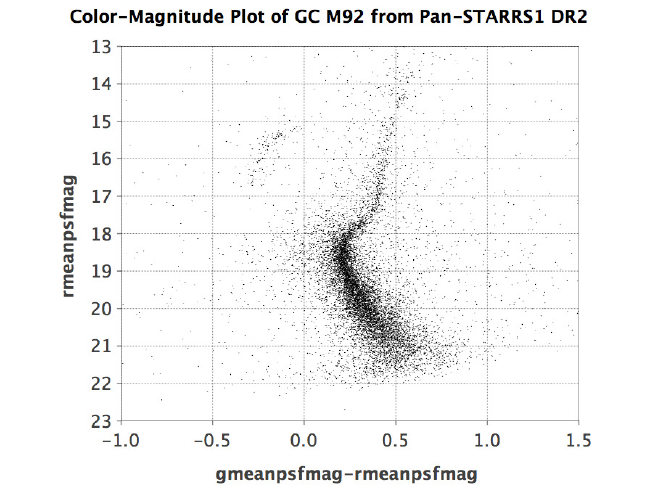
Figure 9. Color-magnitude diagram for the globular cluster M92, made by